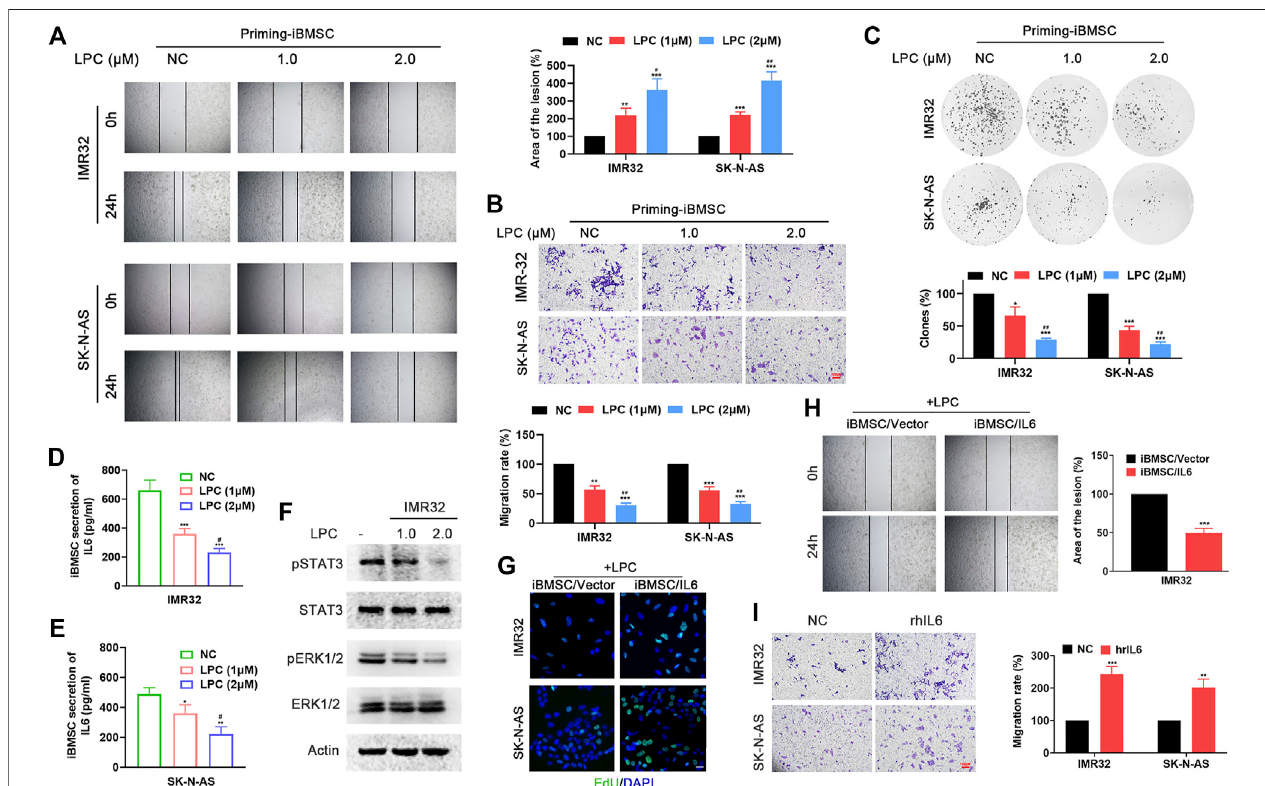
FIGURE4| LPChindersthetumorigeniceffectofiBMSCbyinhibitingthesecretionofIL6inBMSCmediatedbyNBcells.NBcellspretreatedwithdifferentdosesof LPCwerecontinuedtobeculturedinfreshmediumforanother48,thenthesupernatantwasextractedandasLPCpretreatmentconditionmedium(LPC-CM).LPC-CM wasusedtoprime theiBMSC,whichwerethenco-cultured withnon-LPCpretreated NBcellsforanewroundofculture.[ **p < 0.01and ***p < 0.001vs.NC; #p < 0.01, ##p < 0.01 and ###p < 0.001 vs. LPC (1 μ M)] (A) Wound-healing assay. (B) Transwell migration assay. (C) Colony formation assay. (D,E) IL6 secretion in the supernatant of iBMSC cultured with LPC-CM was detected by ELISA. (F) WB method was performed to detect the phosphorylation levels of STAT3 and ERK1/2 in IMR32culturedwithCMfromLPC-CMstimulated-iBMSC.TheCMfromiBMSC/Vector oriBMSC/IL6cellsprimedbyLPC-CMwereusedforculturingwithNBcells. (G) EdU incorporation assay. (H) Wound-healing assay. (I) The supernatant of iBMSC stimulated by LPC-CM was used for NB cells stimulation. ( ***p < 0.001 vs. iBMSC/ Vector) Transwell migration assay was used to detect the migration ability of IMR32 and SK-N-AS cultured with hrIL6 supplemented into LPC-CM stimulated iBMSC supernatant. ( **p < 0.01 and ***p < 0.001 vs. NC) Data represents three independent